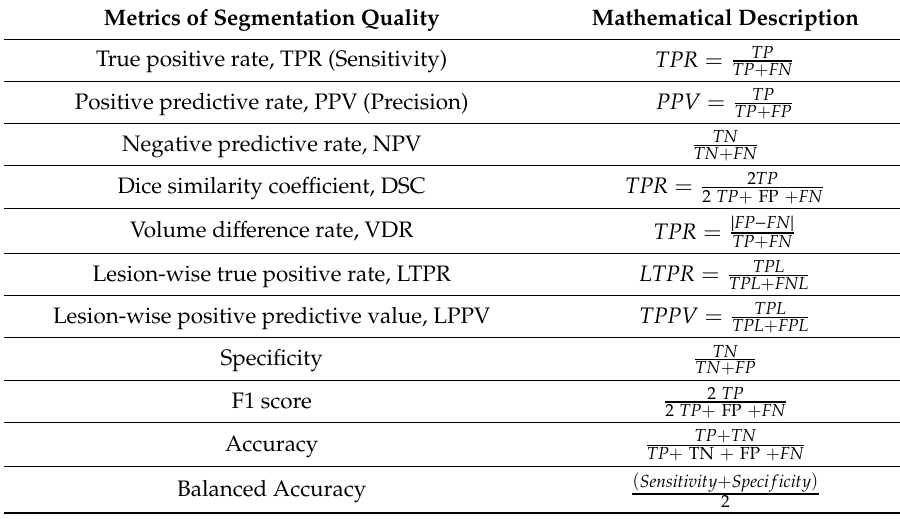
Table 7. Summary of the validation measures of brain segmentation and their mathematical formula regarding the number of true positives (TP), false positives and false-negative (FN) at voxel and lesion levels (TPL, FPL, and